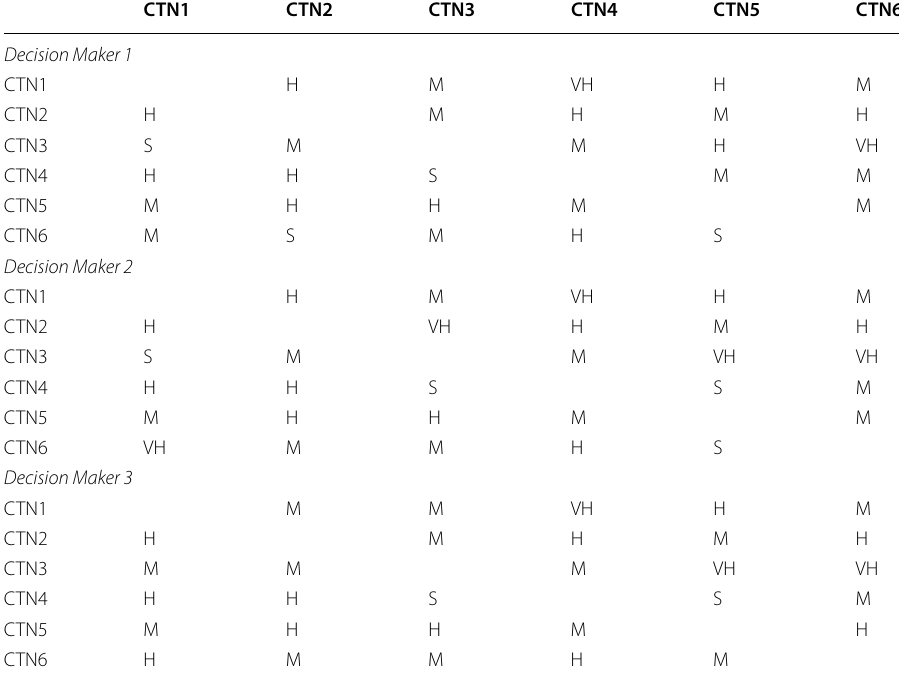
Table 3 Linguistic evaluations